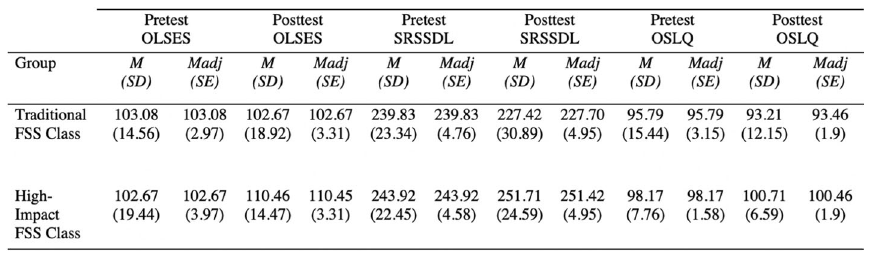
Table 4 Means, adjustment means, standard deviations, and standard errors for the two groups for each